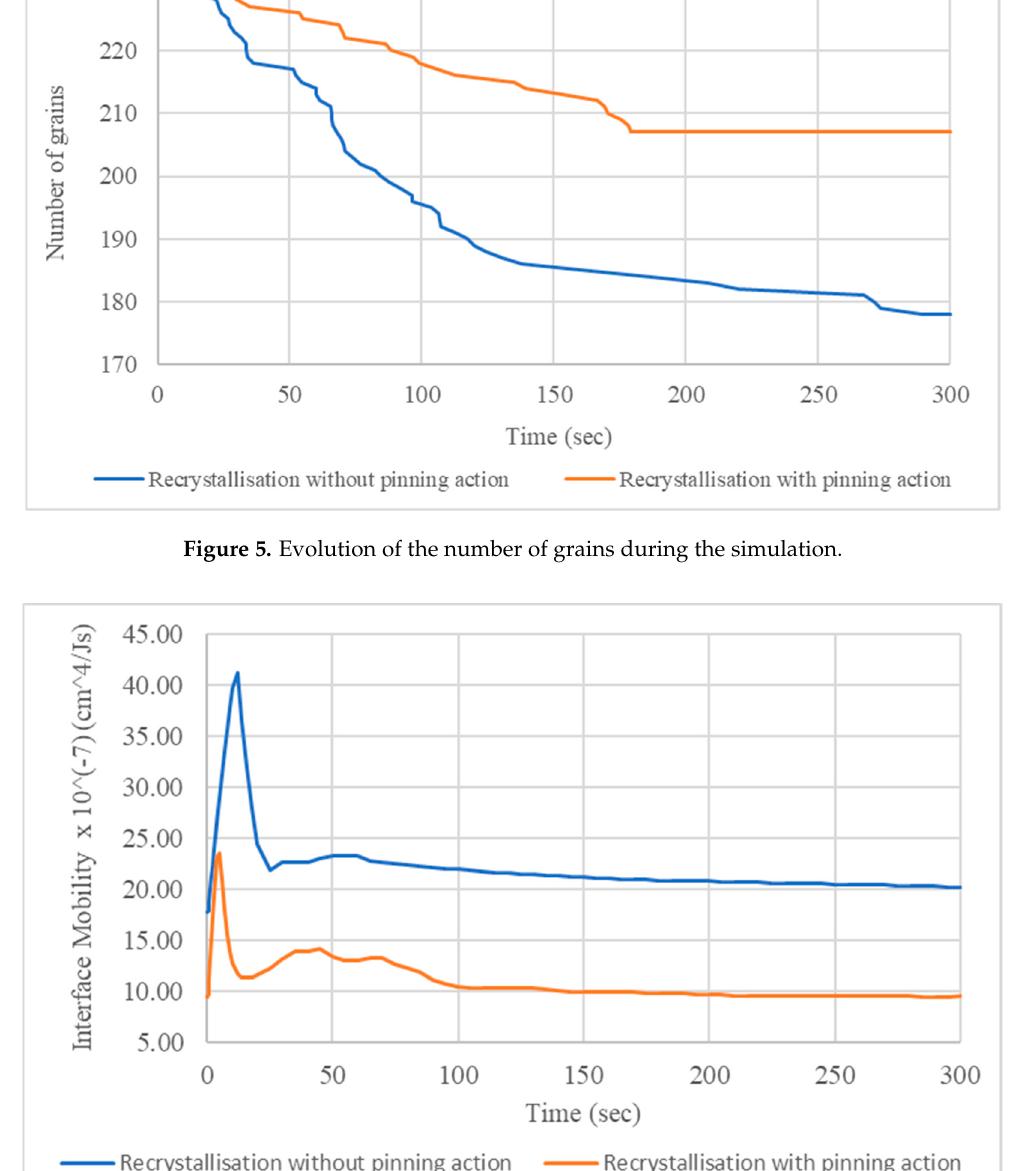
Figure 6. Evolution of interface mobility during the simulation.